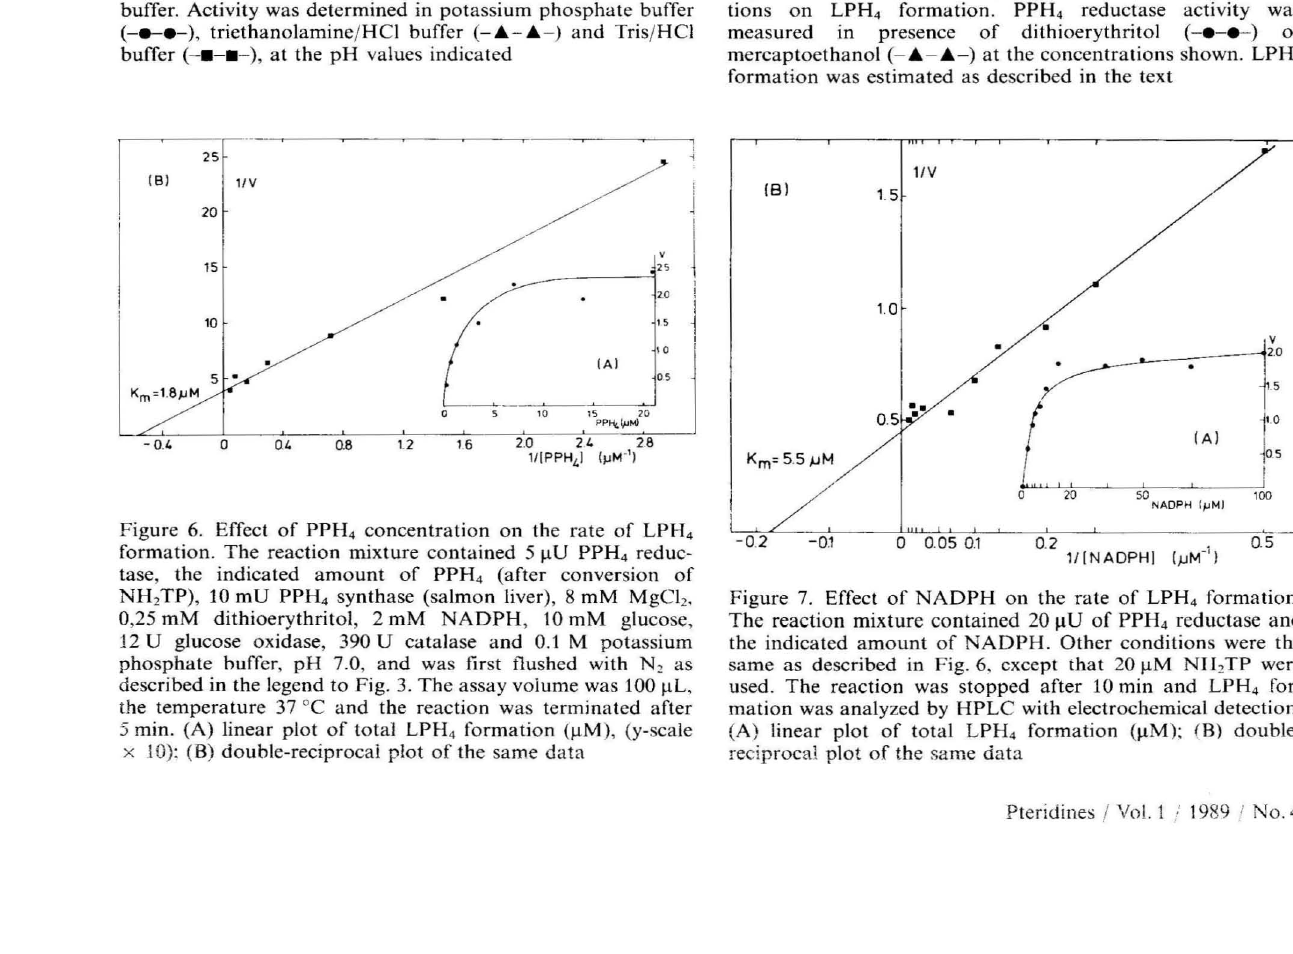
Figure 4. PPH 4 reductase activity as a function of pH and buffer. Activity was determined in potassium phosphate buffer (-e-e-), triethanolamine/HCl buffer (-.&.- .&.- ) and Tris/HCl buffer (- .-.-), at the pH values indicated